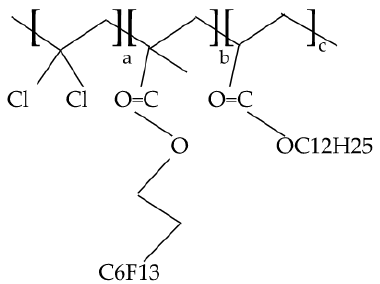
Figure 1. Schematic of a 6:2 fluorotelomer methacrylate polymer [39].